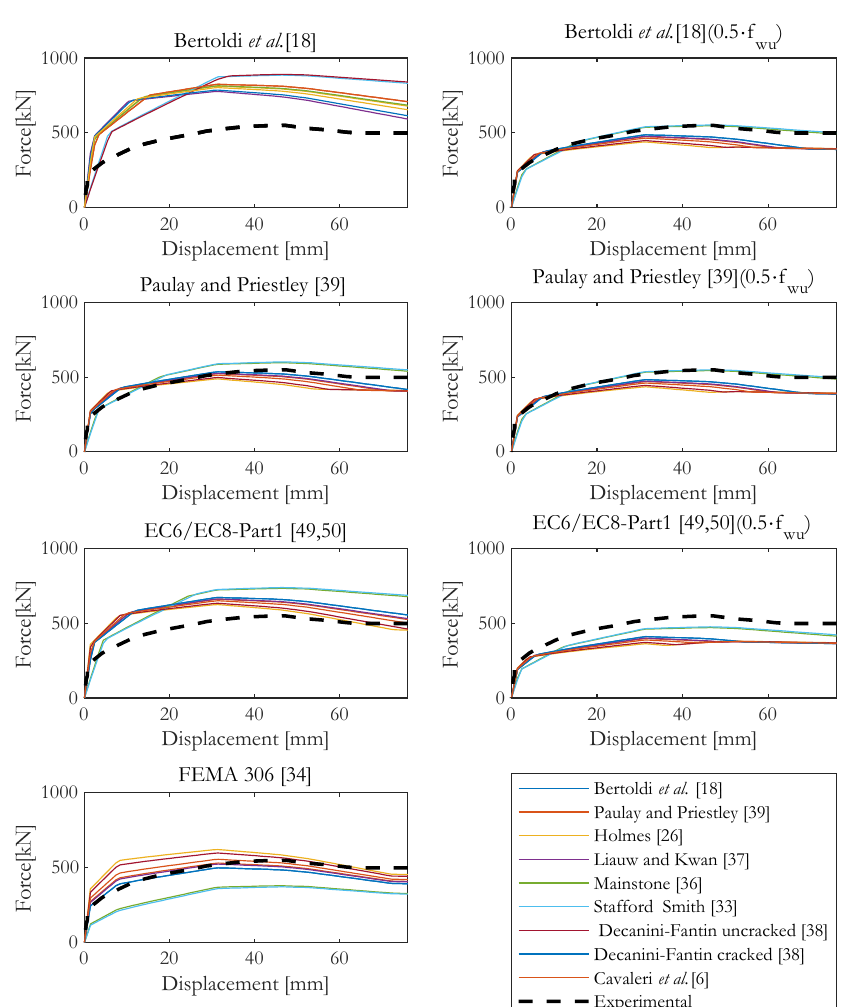
Figure 14. Pushover analysis results as function of the strut width and the strength formulations.